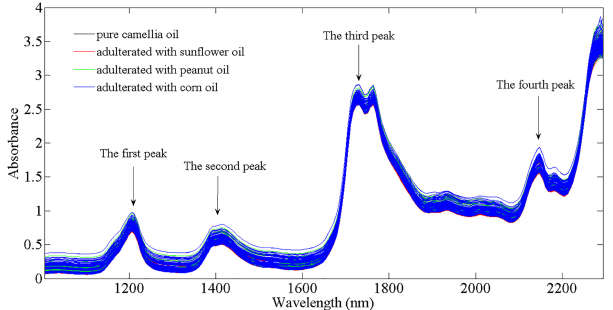
Fig. 1. Original spectra of the pure and adulterated camellia oil